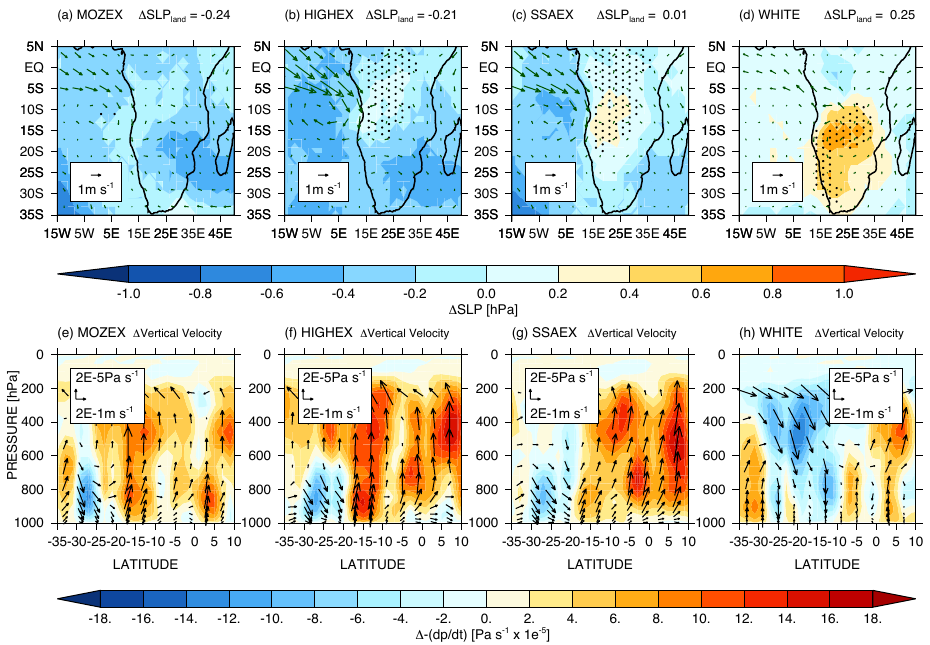
Fig. 8. ASO change in sea level pressure ( 1 SLP) relative to CTRL [hPa] for (a) MOZEX, (b) HIGHEX, (c) SSAEX, and (d) WHITE overlain with 850-hPa wind anomaly [mmd − 1 ] relative to CTRL; black stippling represents 1 SLP above 90% significant. Zonally averaged (0–50 ◦ E) change in vertical velocity ( − dp / dt ) relative to CTRL [Pas − 1 × 1e − 5 ] for (e) MOZEX, (f) HIGHEX, (g) SSAEX, and (h) WHITE overlain with meridional circulation change; note red (blue) shading indicates increased upward motion (relative